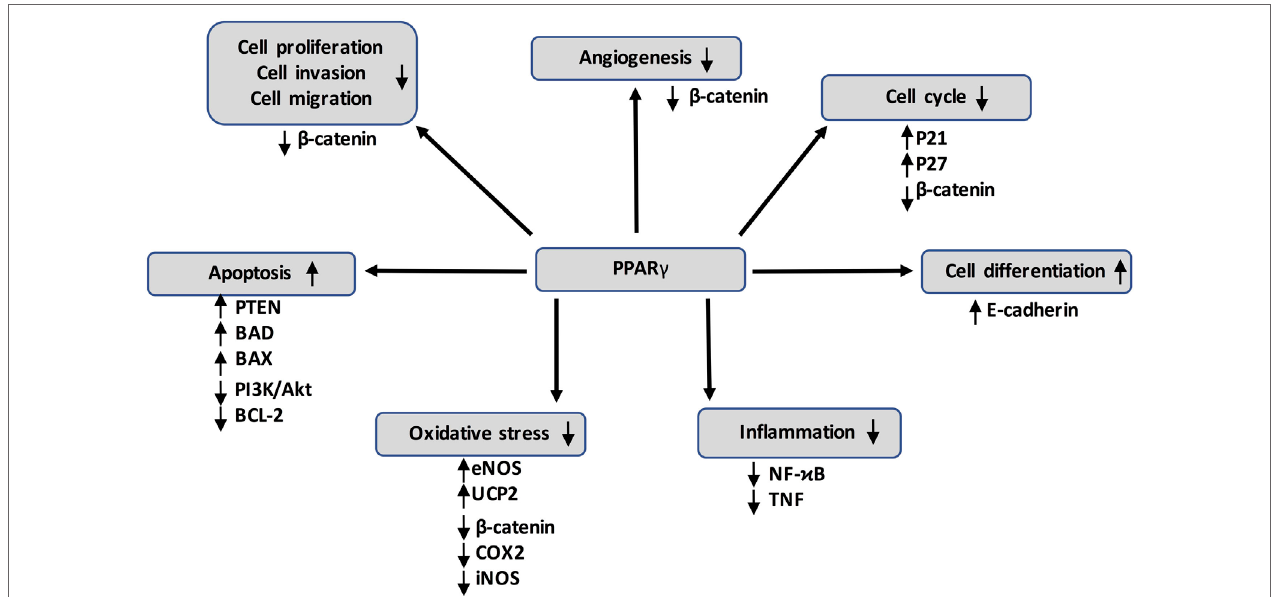
FiGURe 3 | Peroxisome proliferator-activated receptor gamma (PPAR γ ) activation can inhibit cancer development through several mechanisms by acting on numerous target genes and pathways, such as the canonical WNT/ β -catenin pathway. It also interferes with pro-inflammatory signaling by repressing nuclear factor-kappaB (NF κ B) and tumor necrosis factor α (TNF- α